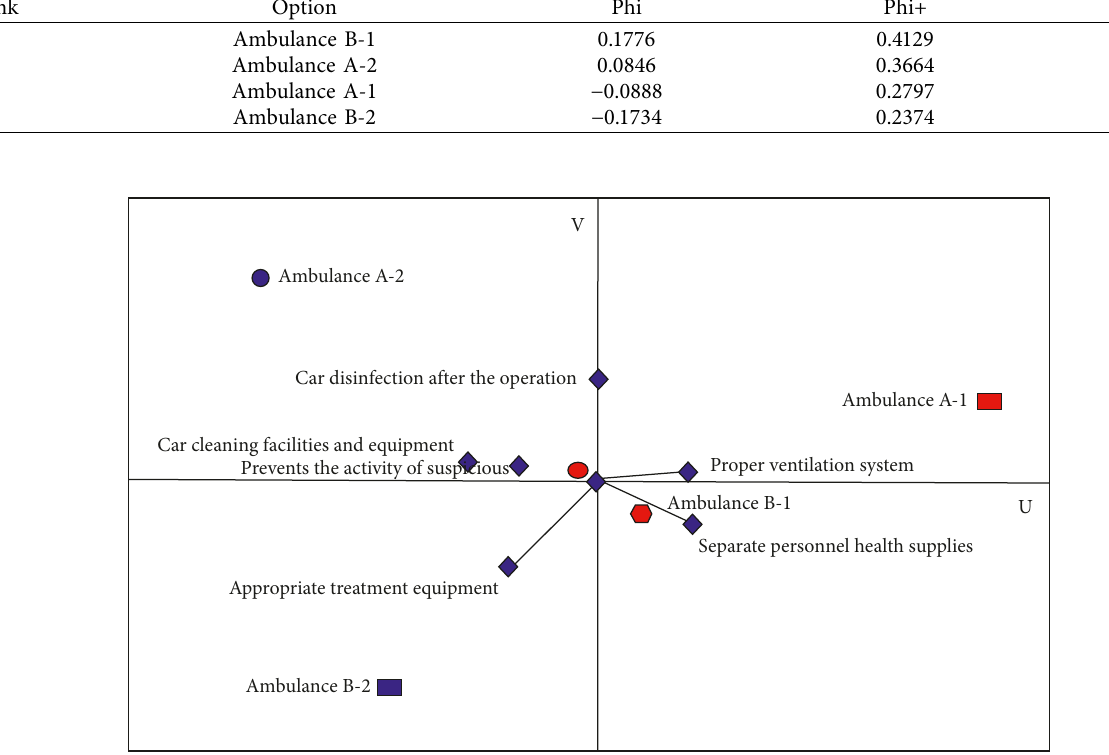
Figure 2: GAIA diagram of